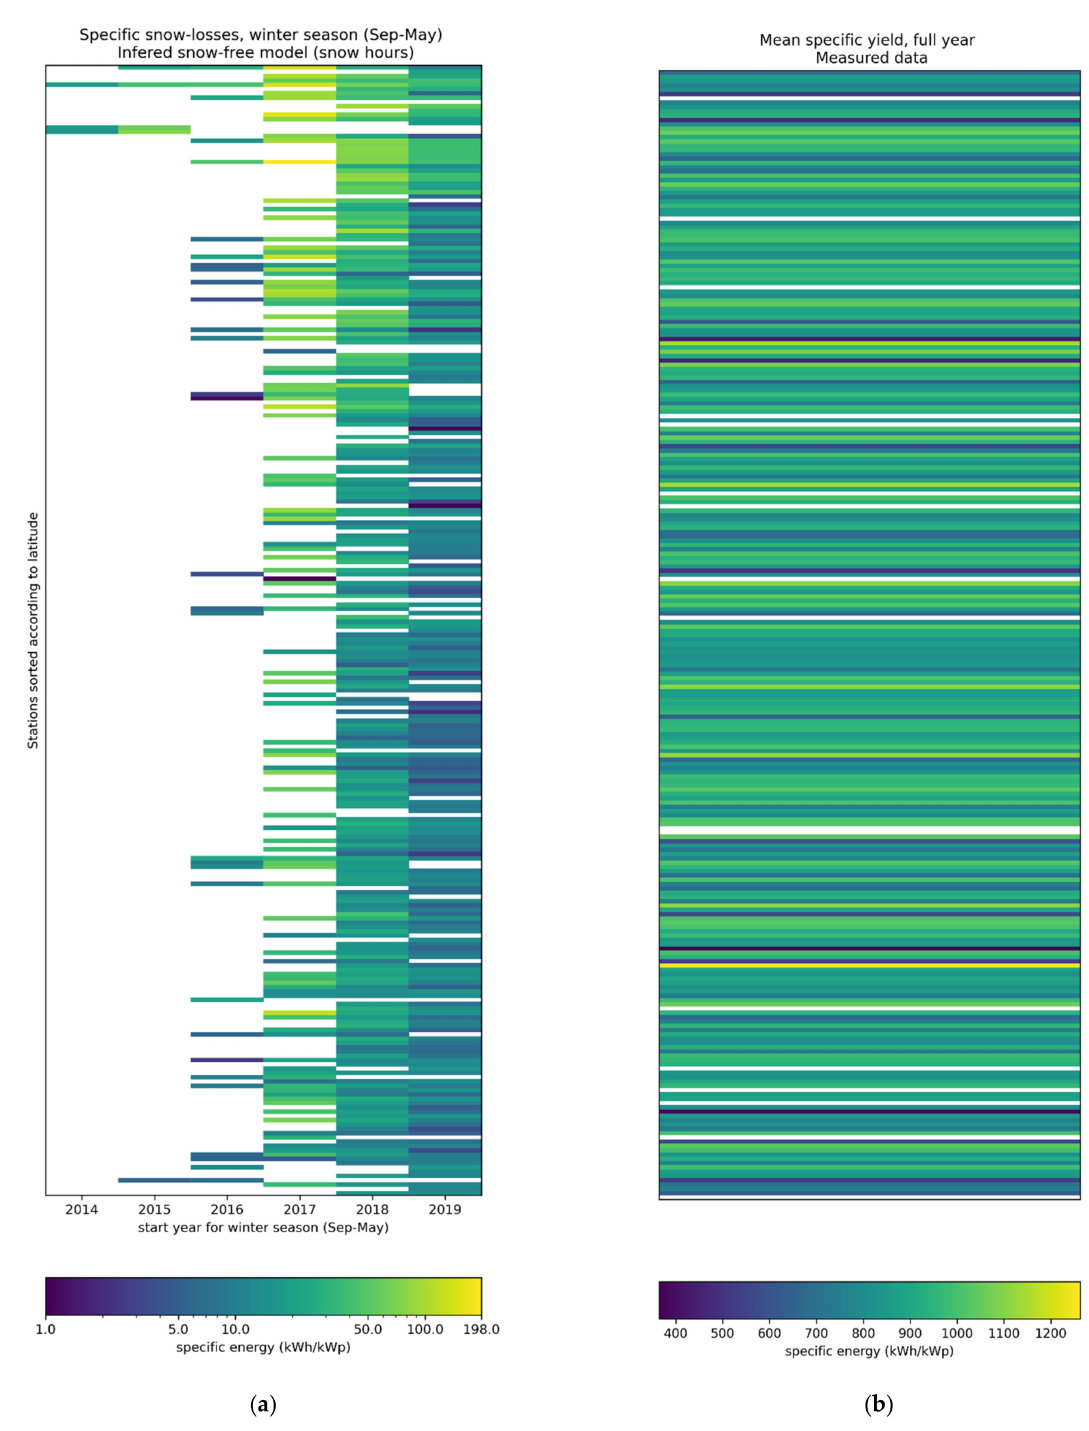
Figure 7. Results of normalized snow loss calculations in relation to the measured annual electricity yield for all quality- passed sites. The sites’ relative positions illustrate their geographical order by latitude: ( a ) estimated snow losses for the months September–May and years 2014–2020 and ( b ) annual mean yield for all years (June–May) with at least 90% data availability. Normalization for both graphs is by installed peak power (direct current at Standard Test Conditions—DC, STC). Relative annual snow losses are illustrated in the boxplot in Figure 8, showing values between 0% and 20%. For the snow-rich winter season of 2017/2018, the mean relative